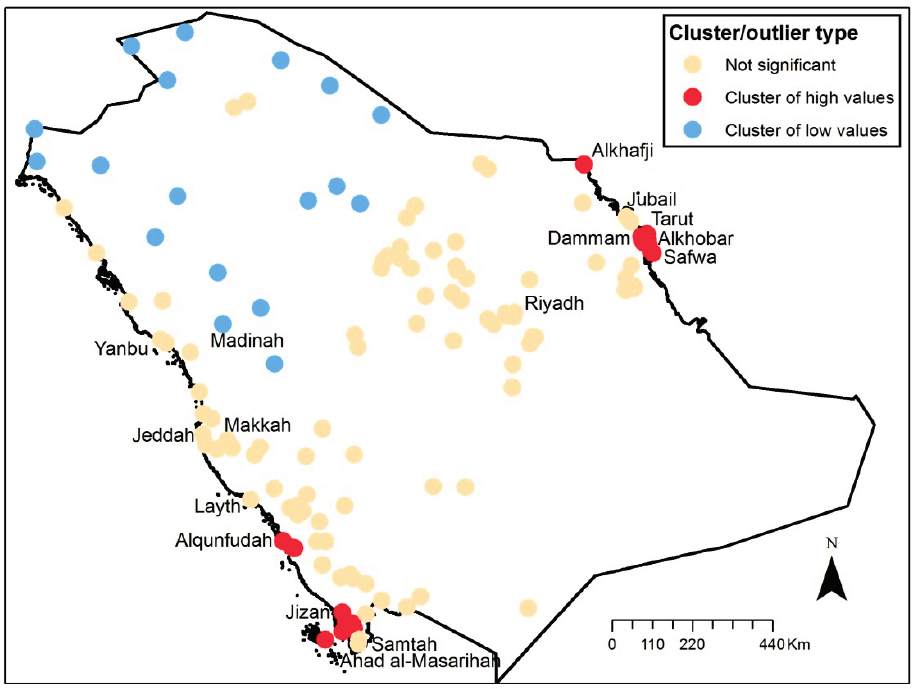
Figure 6. Clusters of PM 2.5 concentrations (un-weighted) in